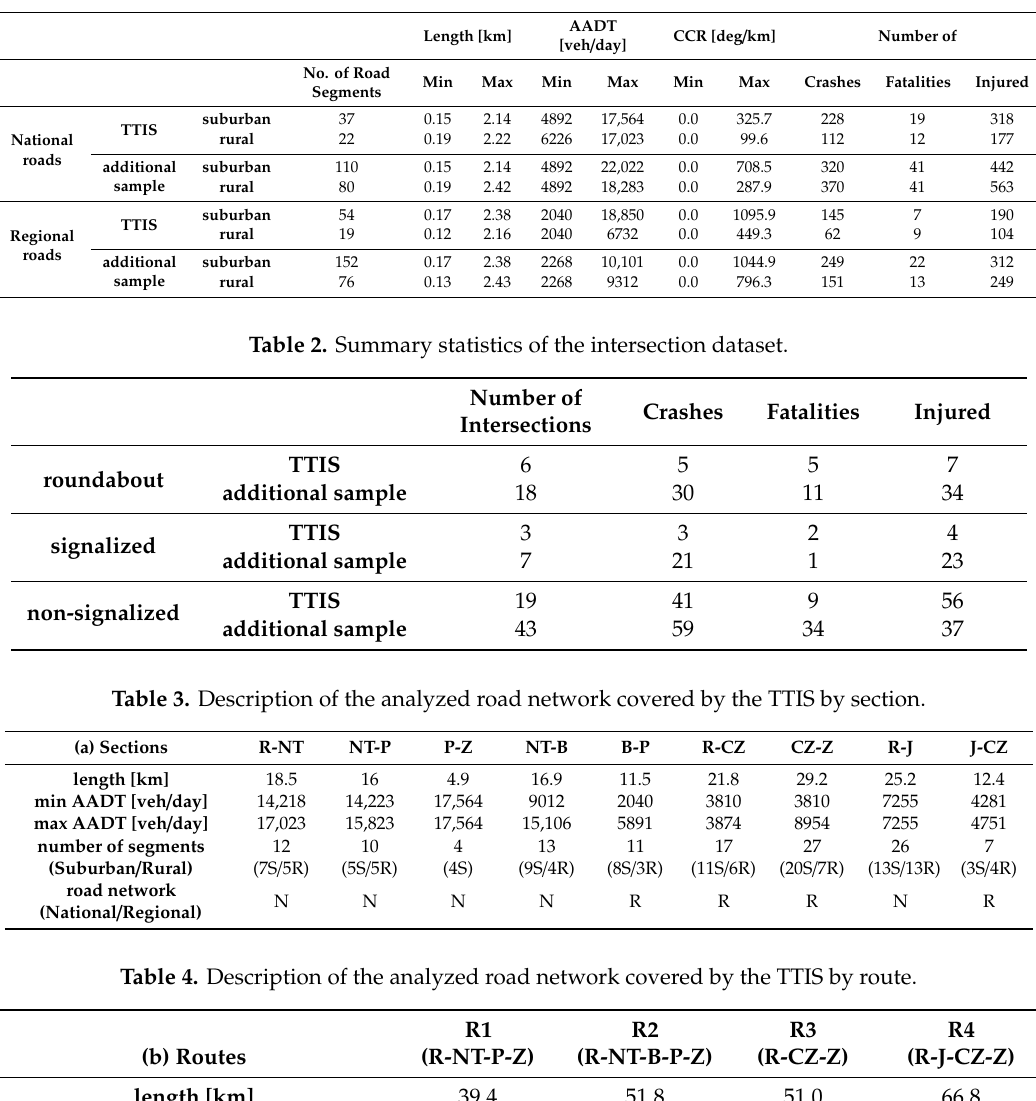
Table 1. Summary statistics of the dataset of road segments (Annual Average Daily Tra ffi c—AADT—is the minimum and maximum in the whole period of analysis / CCR—Curvature Change Rate).